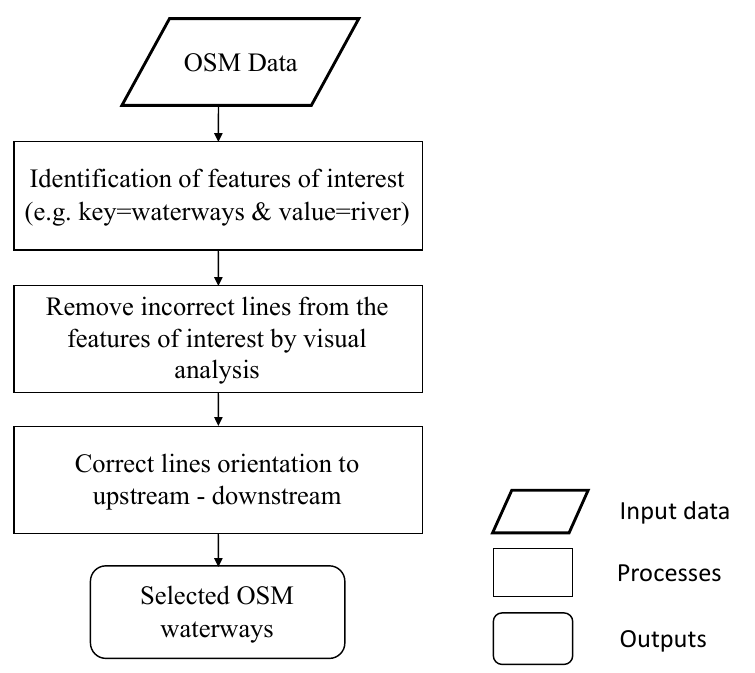
Figure 10. Flowchart of OSM data processing to select the waterways that are used in the creation of the rebuilt DEM.